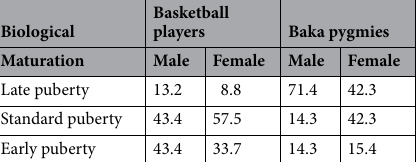
Table 3. Percentage distribution of biological maturation in basketball players and Baka.